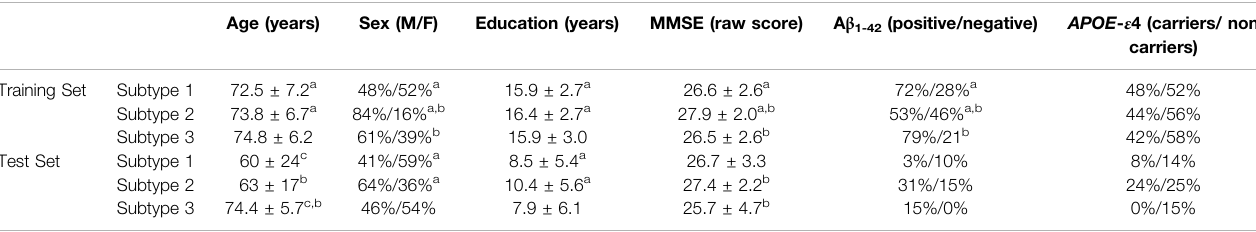
TABLE 4 | Descriptive statistics of the demographic, clinical, biological and genetic variables of subjects for each subtype